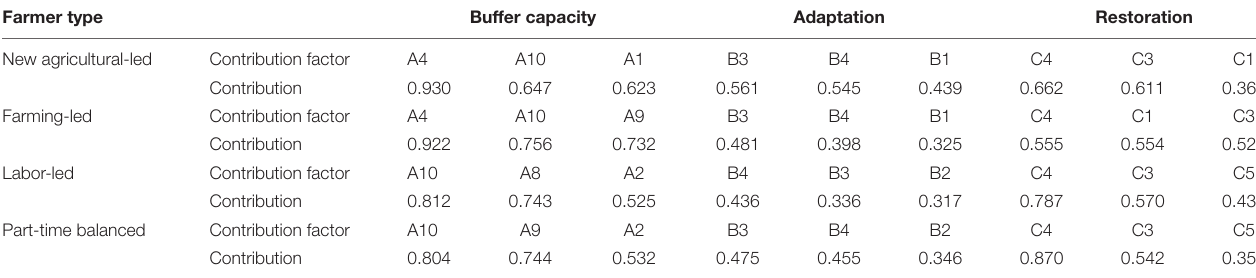
TABLE 4 | Contribution of indicators for each target tier of farm household livelihood resilience. Farmer